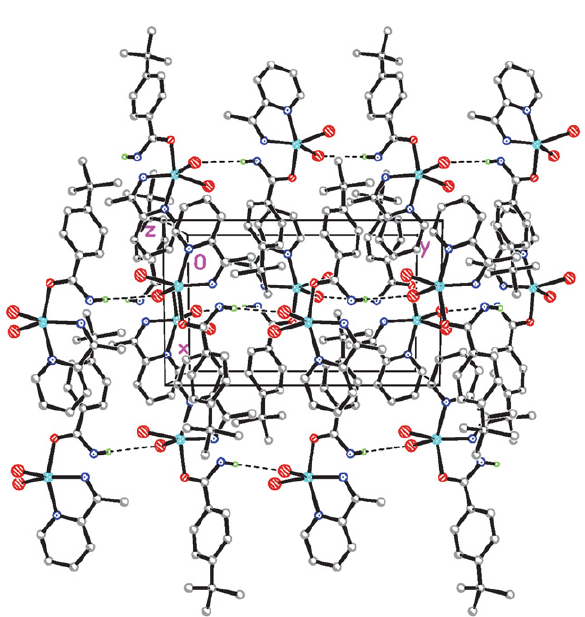
Fig. 2. Molecular packing structure of complex 1 linked by hydro- gen